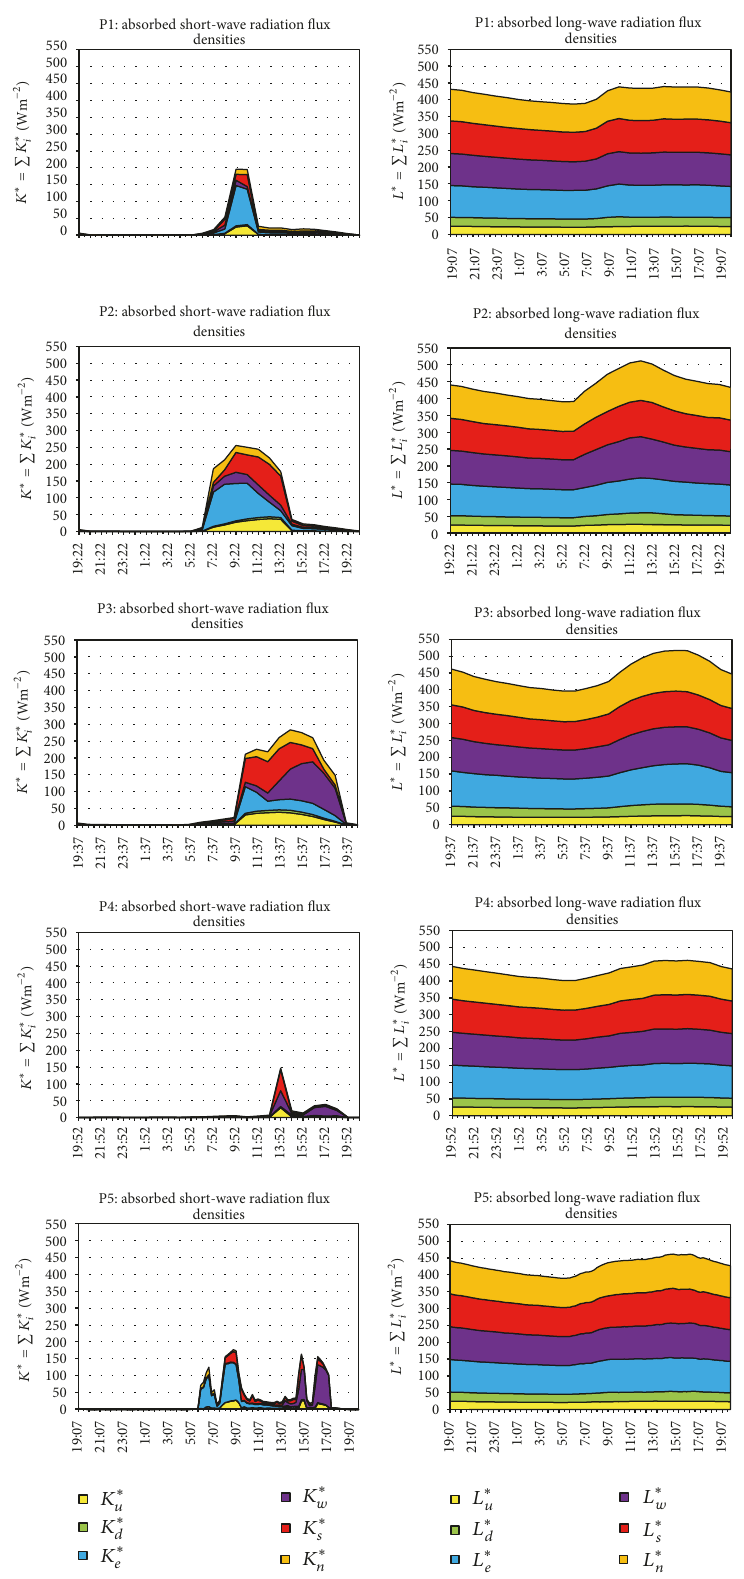
Figure 6: Sum of the short- ( 𝐾 ∗ 𝑖 ) and longwave ( 𝐿 ∗ 𝑖 ) radiation flux densities absorbed by the standing reference person at the five survey points ( 𝑎 𝑘 : 0.7, 𝑎 𝑙 : 0.97, 𝑊 𝑖 : 0.06 for vertical directions and 0.22 for lateral